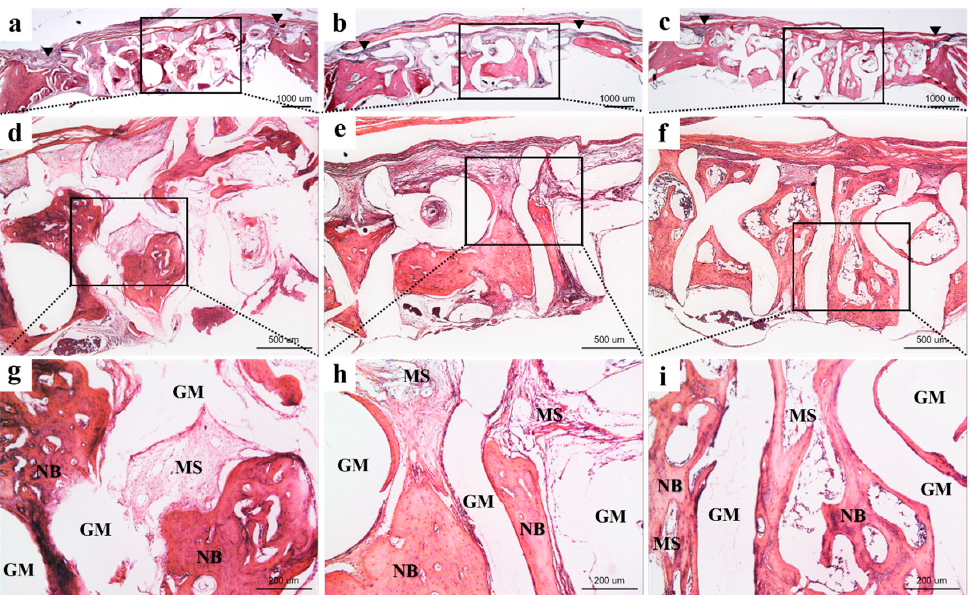
Figure 7. Representative tissue slides at 4-weeks post-surgery: ( a , d , g ) Boneplant; ( b , e , h ) Bonplant/CMC; and ( c , f , i ) Boneplant/CMC/BMP groups. Note: NB = new bone; MS = marrow space; GM = bone graft material. Arrow head = margin of defect (H&E stain, original magnification: ( a , b , c ) ×12.5, ( d , e , f ) ×40, ( g , h , i ) ×100).